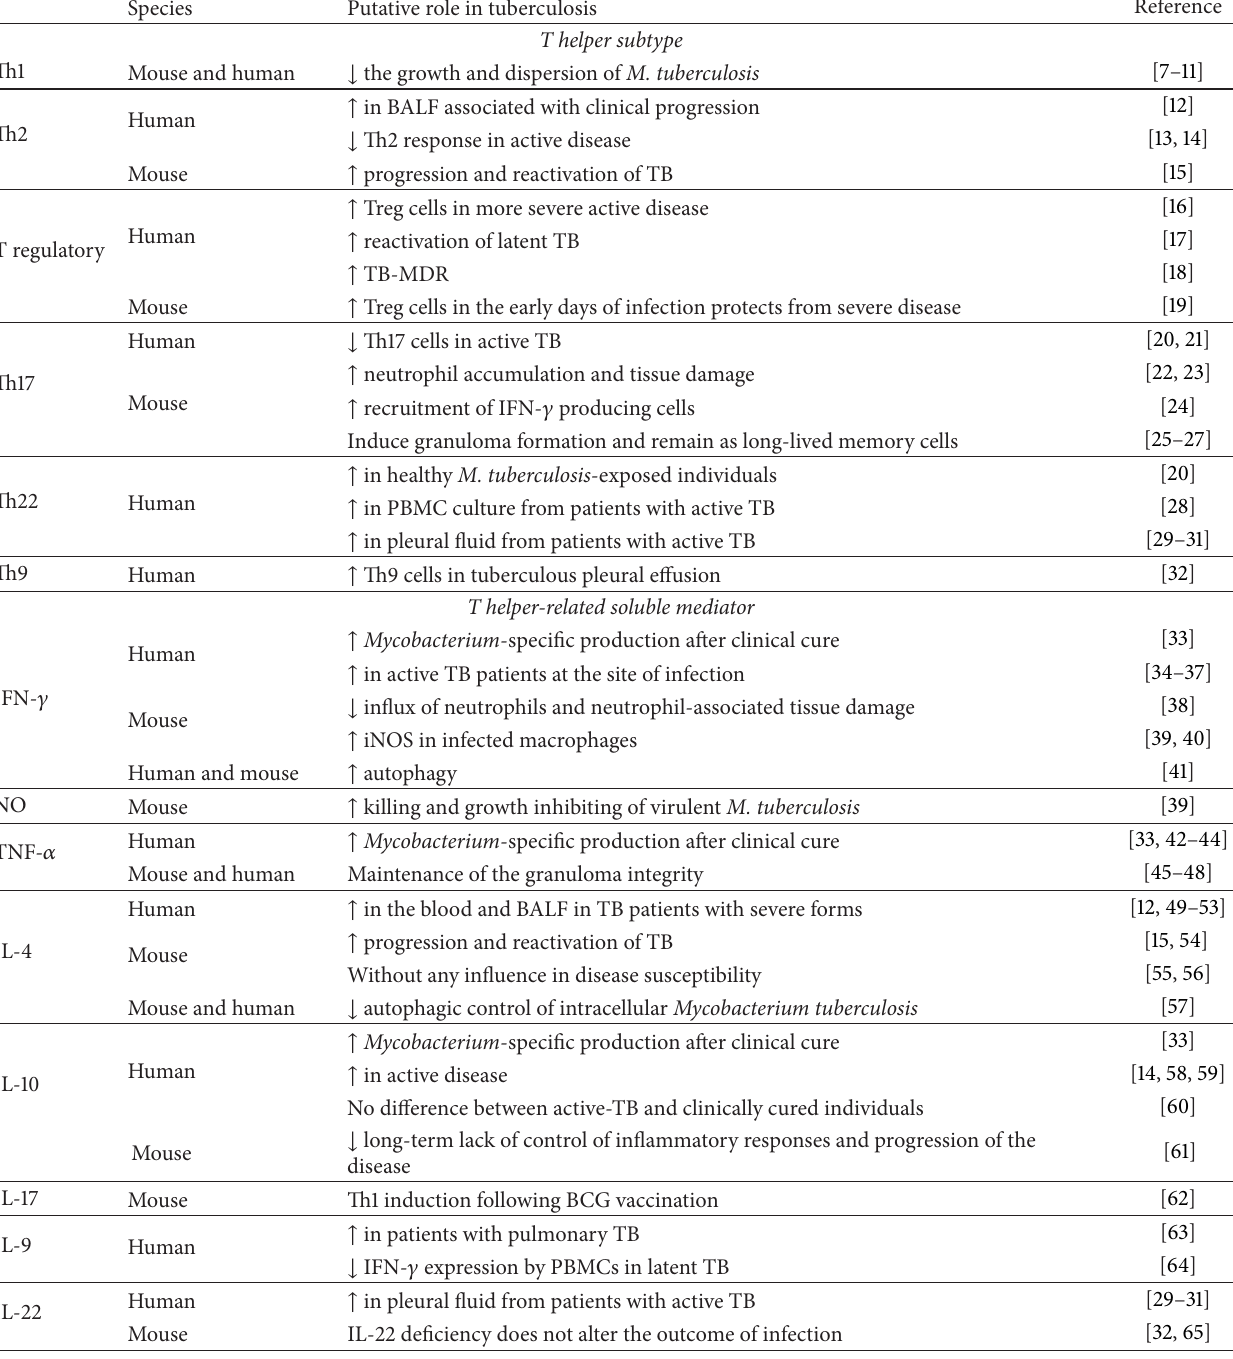
Table 1: T helper cell (Th) subtypes and Th-related soluble mediators in human and experimental tuberculosis.